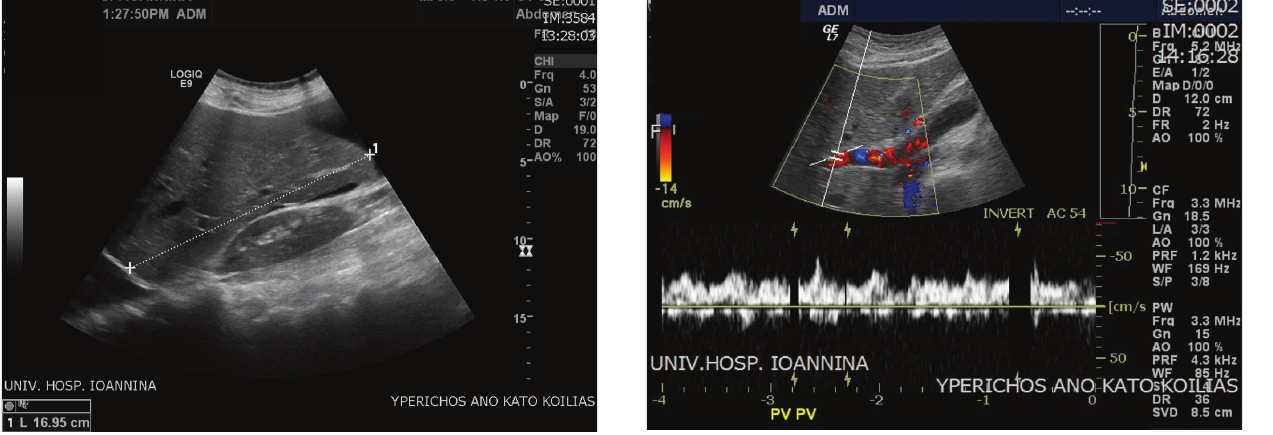
Figure 2: Hepatomegaly.